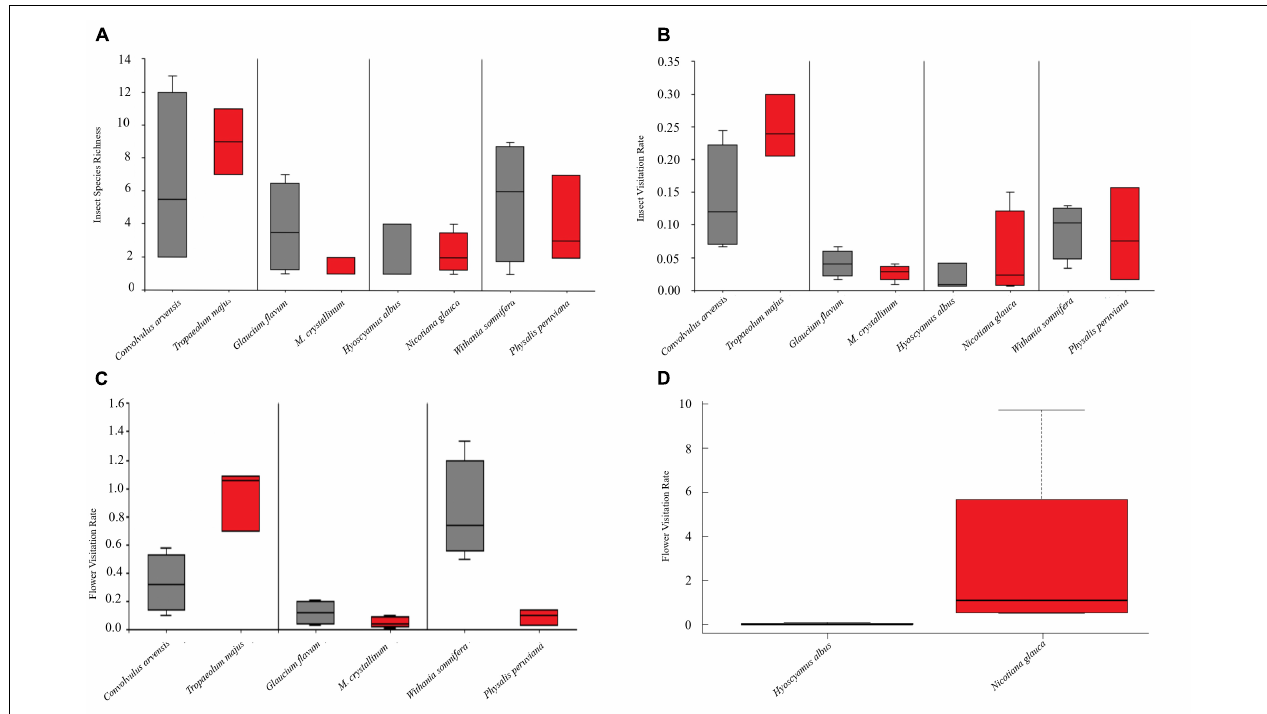
FIGURE 2 | Mean and SD of insect species richness SR (A) , insect visitation rate IVR (B) and flower visitation rate FVR (C,D) to native (in gray) and non-native (in red) plant species studied. SR is the number of insect species visiting the flowers, IVR is the number of legitimate visits regardless the number of flowers contacted, and FVR is the number of flowers contacted by each insect species, standardized by the number of flowers observed in each census and by total flower abundance of the plant species.